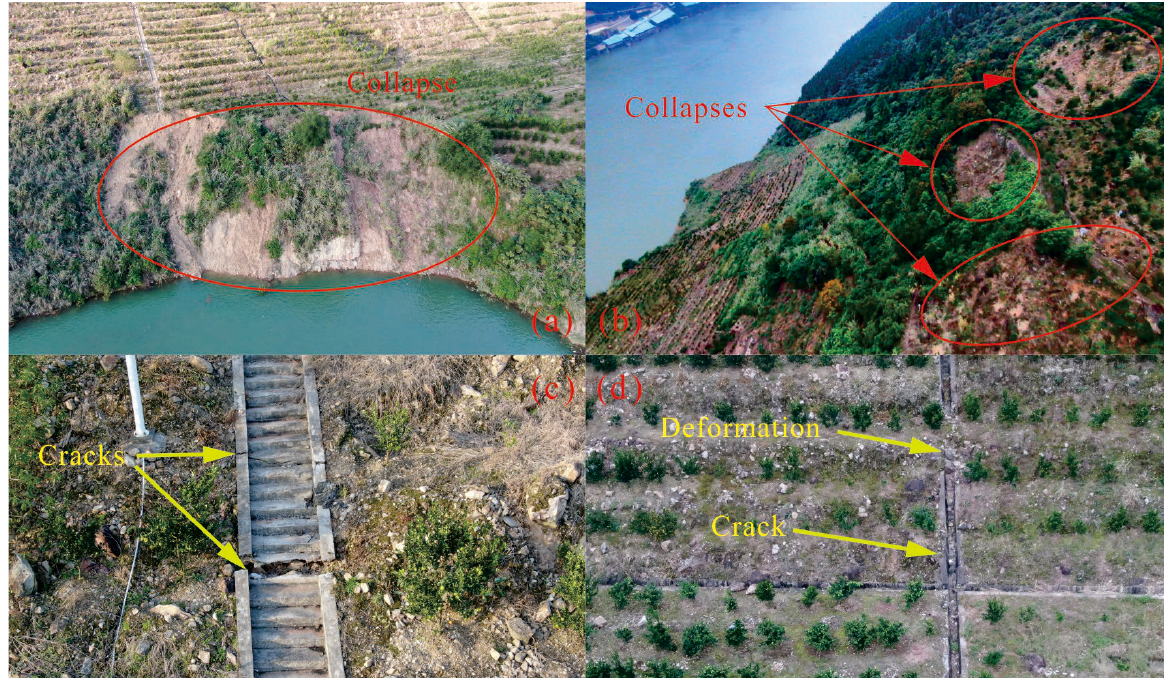
Figure 6. The ground collapses ( a , b ) and cracking ( c , d ) in the toe area captured by UAV, October 2020.